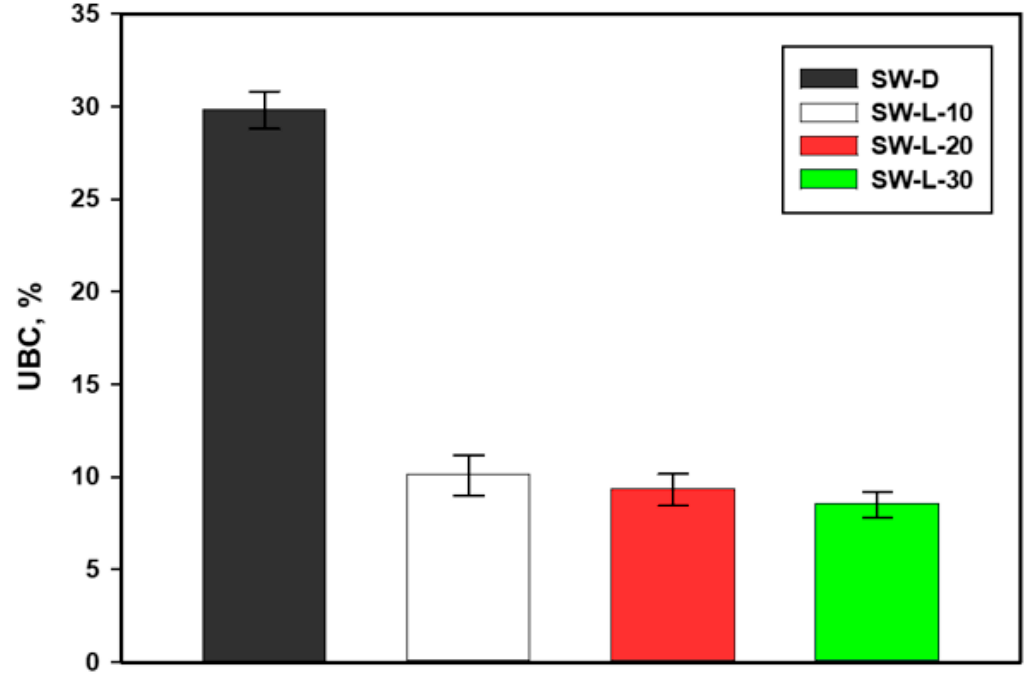
Figure 7. UBC emissions of SW-D and HSFs.